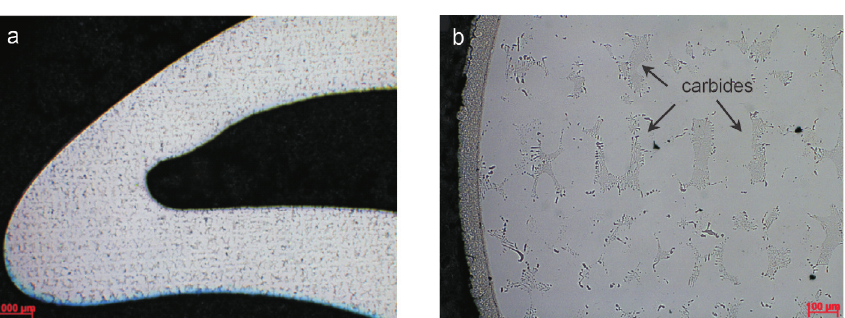
Fig. 2. The microstructure of the blade No. 1: a) cross-section by the blade locking, the dendritic struc - ture, b) carbides particles with the "Chinese-script" morphology, LM